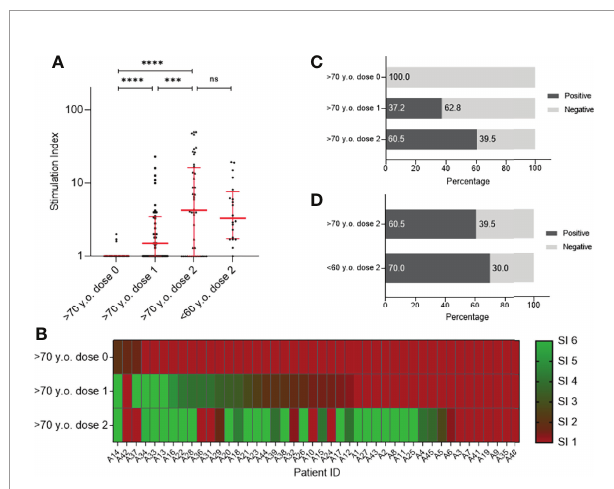
FIGURE 1 | Analysis of T cells against SARS-CoV-2 spike using sera from participants older than 70 years (n = 45) before vaccination (dose 0), after fi rst- (dose 1) and after second vaccination (dose 2) with BNT162b2 in contrast to fully vaccinated participants younger than 60 years (n = 20). The ELISpot assays were performed using precoated human SARS-CoV-2-speci fi c IFN g ELISPOT kits. Results are presented as a Stimulation Index (SI). (A) T cell responses against SARS-CoV-2 spike are shown as individual progression for each person (>70 y.o.) until full immunization with BNT162b2. In contrast, individual SARS- CoV-2 T cell responses are illustrated for people younger than 60 years of age fully vaccinated with BNT162b2. Medians are visualized together with the interquartile range as an error bar. Statistical signi fi cance between values of the three different time points for the group >70 y.o. was determined using the Wilcoxon test. A Mann – Whitney – U test for nonparametric distribution was applied for comparison of immune responses between the two age groups. [p > 0.05 not signi fi cant (ns), p ≤ 0.001 (***) and p ≤ 0.0001 (****)]. (B) Heat map visualizing individual progression of T cell response against SARS-CoV-2 spike before and after vaccination with BNT162b2. Illustrated colors shift from red for a negative to green for a positive antibody status. (C) Percentages of participants with positive or negative T cell response against SARS-CoV-2 spike is shown for time points before-, after the fi rst- and second vaccination. (D) Comparison of percentages of persons older than 70 years and people younger than 60 years with positive or negative T cell response against SARS-CoV-2 Spike after second